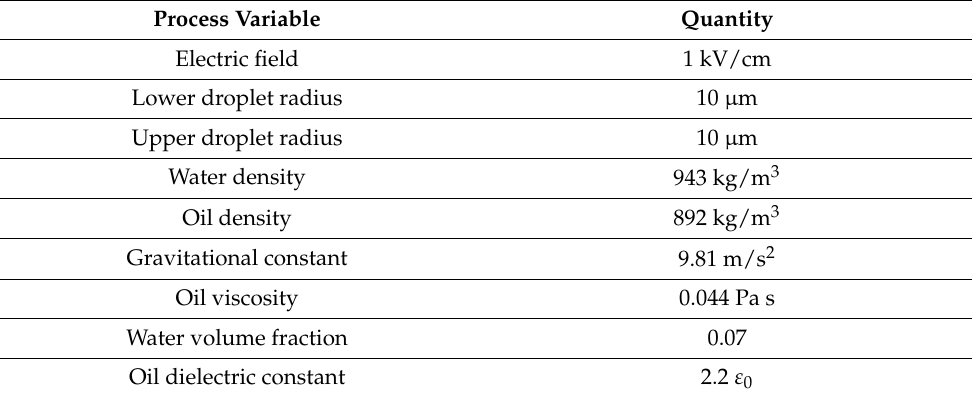
Table 2. Operating conditions of a case with standard conditions.